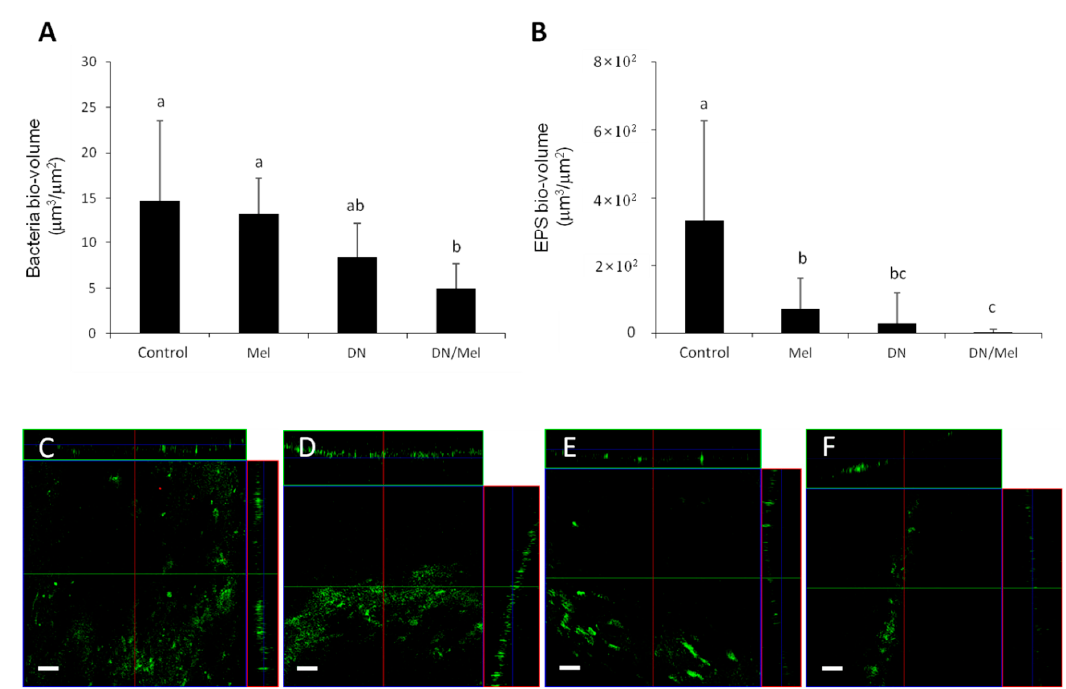
Figure 2. Determination of bio-volume of bacterial cells and extracellular polymeric substances (EPS) through confocal laser scanning microscopy (CLSM) analysis. ( A ) Bacteria bio-volume, ( B ) EPS bio-volume, and ( C–F ) representative CLSM images of E. faecalis biofilms grown on specimens. ( C ) Control ( D ) melittin, ( E ) DNase, and ( F ) DNase/melittin. Values followed by the same superscripts are not significantly different ( p > 0.05). Mel: melittin, DN: DNase, DN/Mel: DNase+melittin. Scale bar = 100 µm.